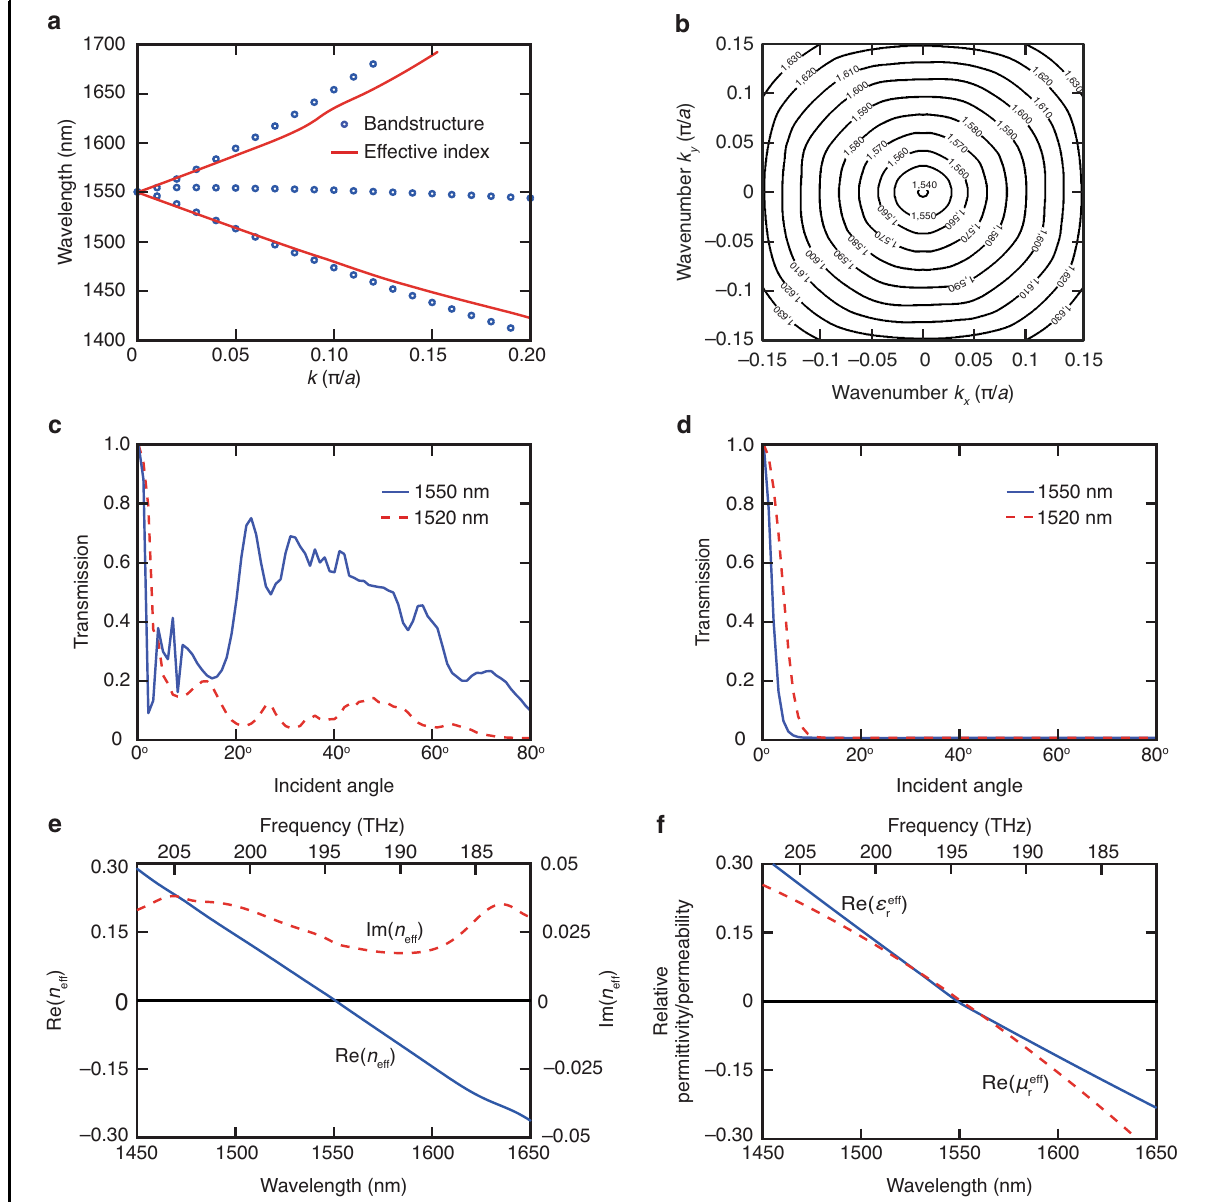
Fig. 2 Optical properties of a DCZIM consisting of a square array of silicon pillars in a SU-8 background matrix. a Comparison of band structures computed by determining the angular frequencies as a function of wave vector for all the Bloch modes (blue dots) and by k = n eff ω /c with the retrieved effective index n eff (red curve). b Iso-frequency contours. Angle-dependent transmissions of the metamaterial ( c ) and its bulk homogenized model ( d ). Retrieved effective index ( e ) and effective permittivity and permeability ( f